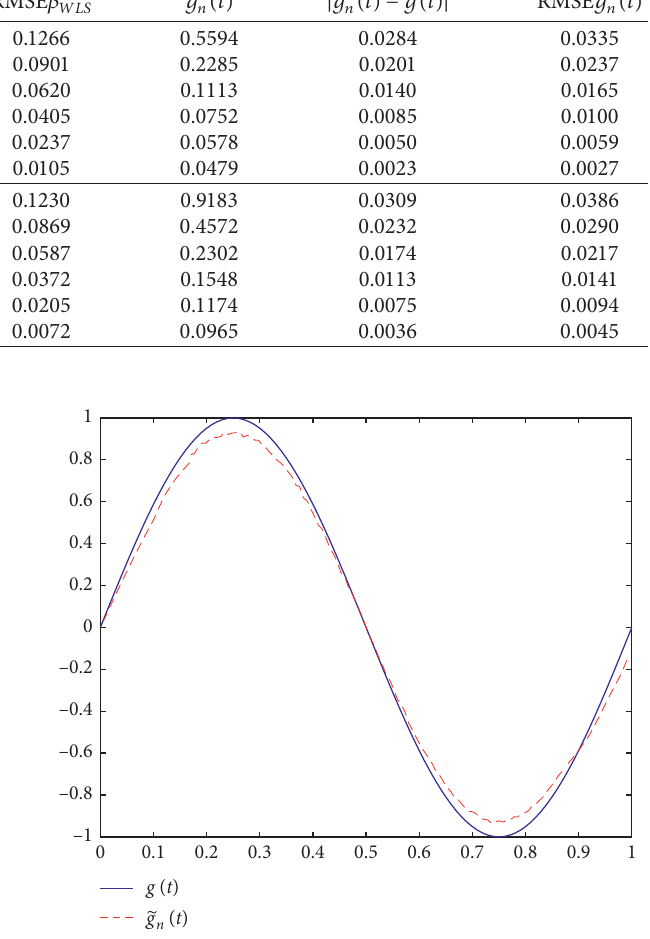
Figure 1: Curves of g ( t ) � sin ( 2 π t ) and 􏽢 g n � 1500.